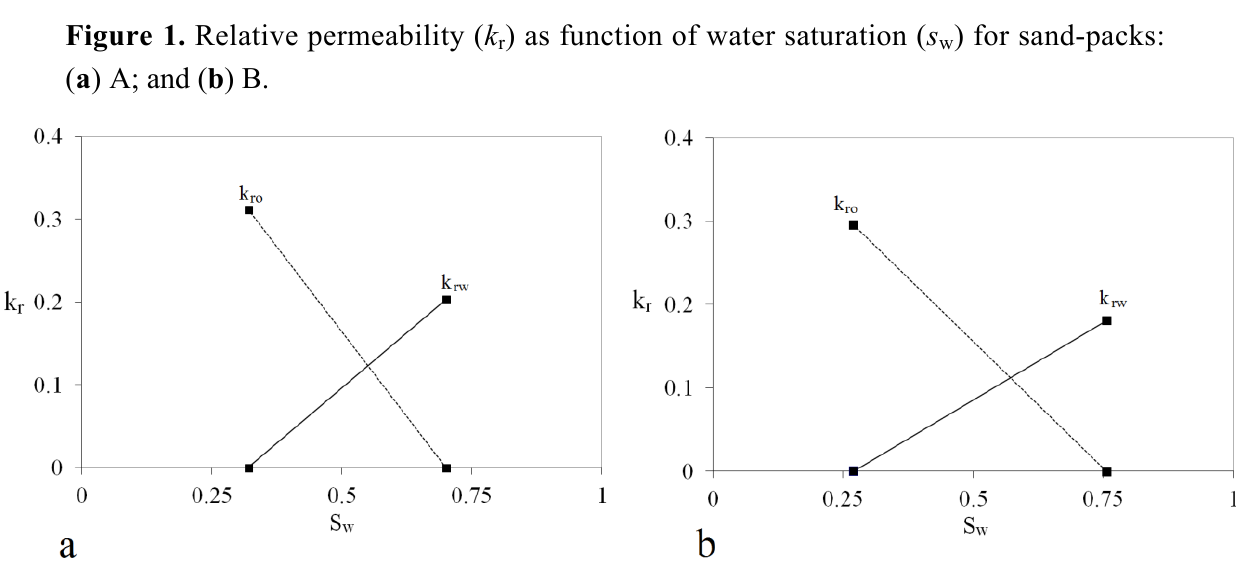
) as function of water saturation ( s r